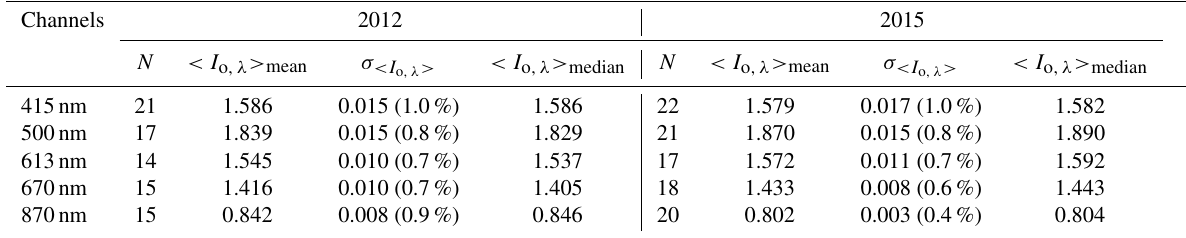
Table 3. MFRSR final extraterrestrial calibration estimates for the years 2012 and 2015 based on the mean ( < I o ,λ > mean ) results and median ( < I o ,λ > median ) of individual Langley plot calibration from Tables 1, 2 and tables in the Supplement. The uncertainty estimation ( σ <I is based on the correspondent standard error of the